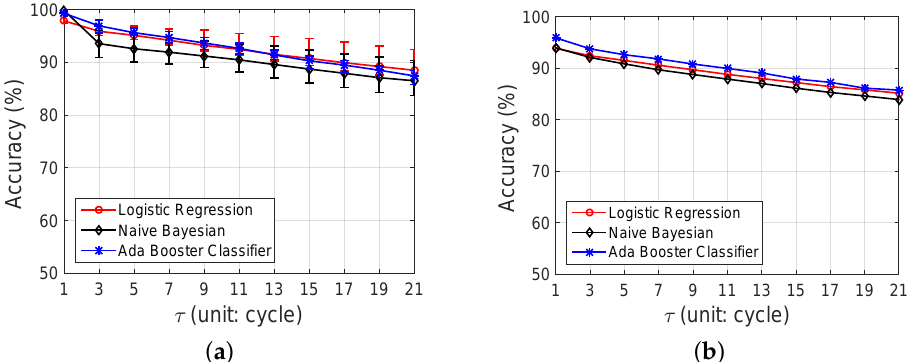
Figure 11. The prediction accuracy of node status with three classification algorithms: Logistic Regression, Naive Bayesian and Ada Booster Classifier. ( a ) Training classifiers for each node with three classification algorithms; ( b ) Training a universal classifier for the network with three classification